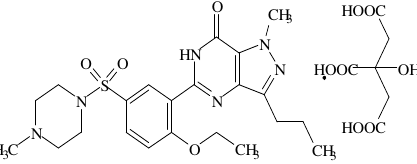
Figure 1 . Structure of sildenafil citrate